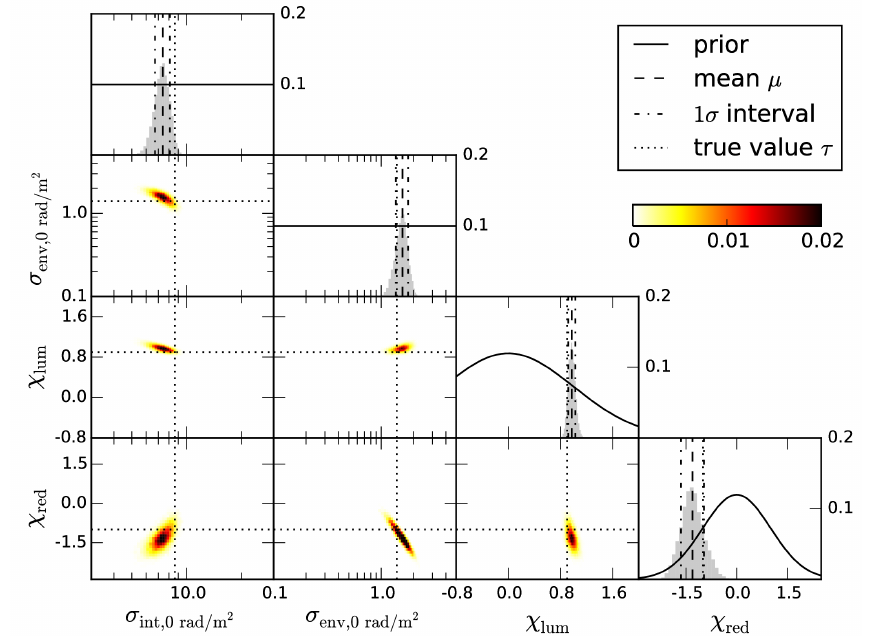
Figure 5. Results obtained for a mock LOFAR catalog produced with observations at 150MHz for ≈ 2200 sources and an overall extra-galactic standard deviation ≈ 7rad/m 2 , corresponding to magnetic field strengths in the large-scale structures of ∼ µ G [46]. Top plots of each column contain the one-dimensional projection of the posterior along with the true value of the parameter (dotted line), the outcome of the analysis (dashed and dash-dotted lines), and the prior (continuous line). The panels in color contain the two-dimensional marginalization of the